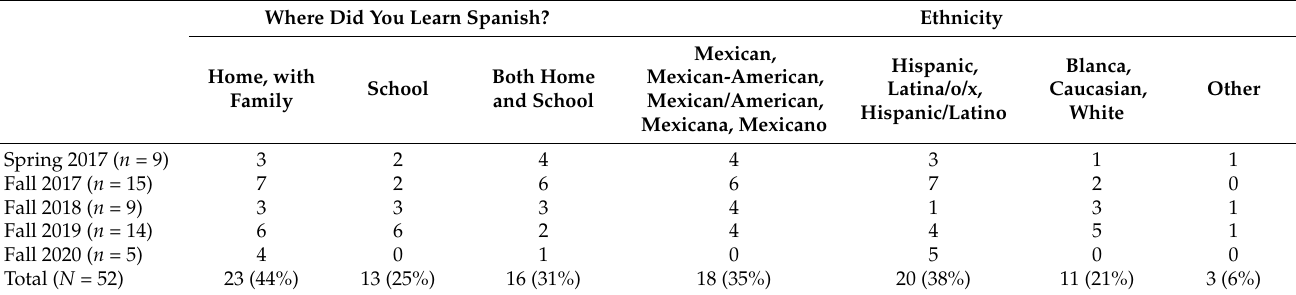
Table 3. Ethnicity and location(s) of Spanish